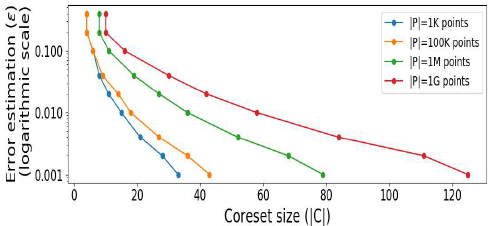
Figure 2. Coreset’s size vs. approximation error ε . Experiments on synthetic data points P of different sizes (in colors). The error (y-axis) decreases with coreset’s size (x-axis).